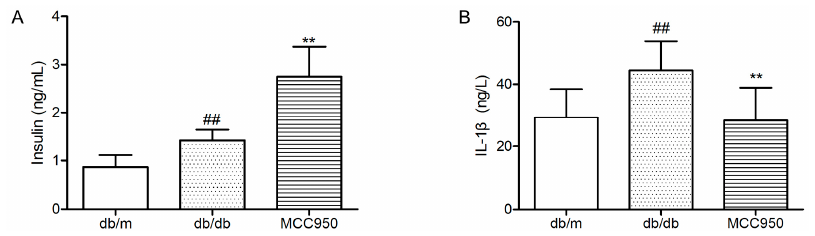
Figure 6. Effects of MCC950 on IL-1 β , and insulin levels in plasma of db/db mice. ( A ) Levels of insulin in the plasma samples of mice; ( B ) Levels of IL-1 β in the plasma samples of mice. All data are represented as mean ± SD ( n = 8). ## p < 0.01, compared with the db/m-group; ** p < 0.01, compared with the db/db-group.